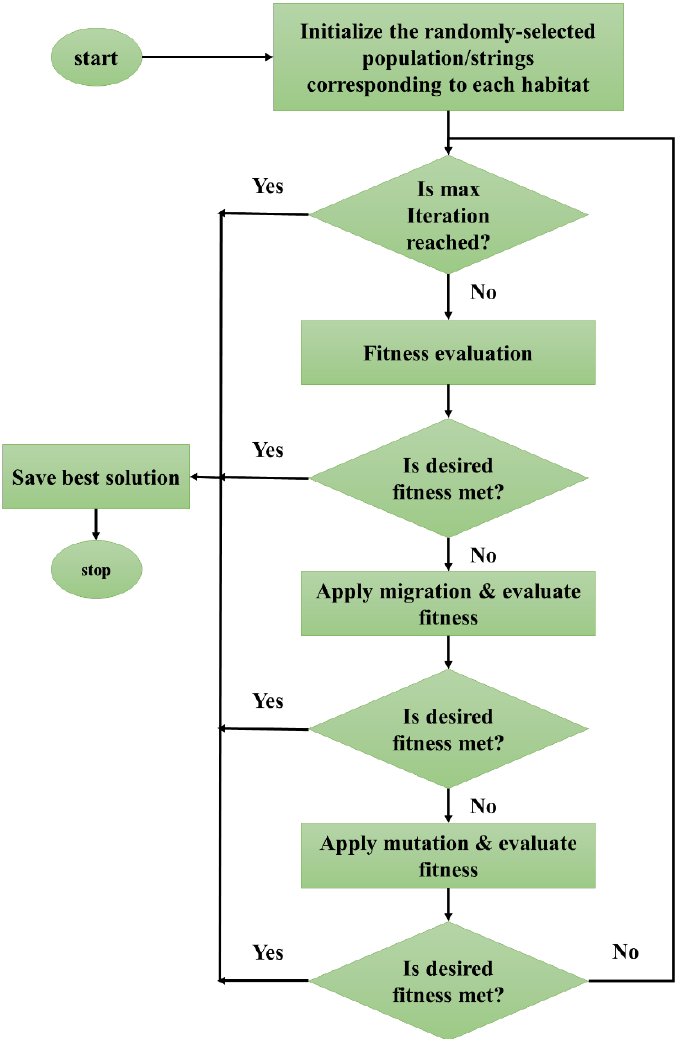
Figure 8. The flowchart of the biogeography-based optimization (BBO) algorithm